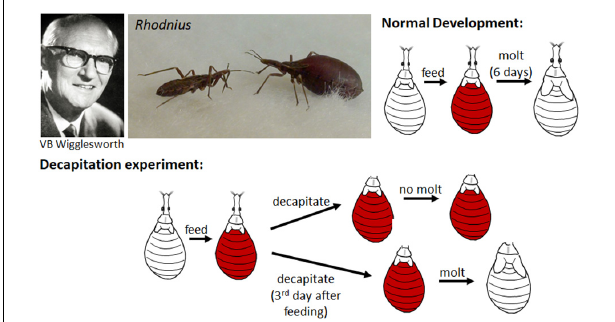
FIGURE 1 | Top : Vincent B. Wigglesworth (left); non-fed (left) and blood-fed (right) nymphs of Rhodnius prolixus (center); cartoon of the normal development of a nymph which after feeding on a blood meal (orange) molts to the next nymphal instar 6 days later. Bottom : Cartoon of decapitation experiments shows that decapitation immediately after feeding prevents the molting but decapitation 3 days after feeding does not. Photos of Wigglesworth from Phillips (2004) and of Rhodnius taken by Timothy Bradley and Catherine Loudon from Knight (2014) (reproduced with permission).